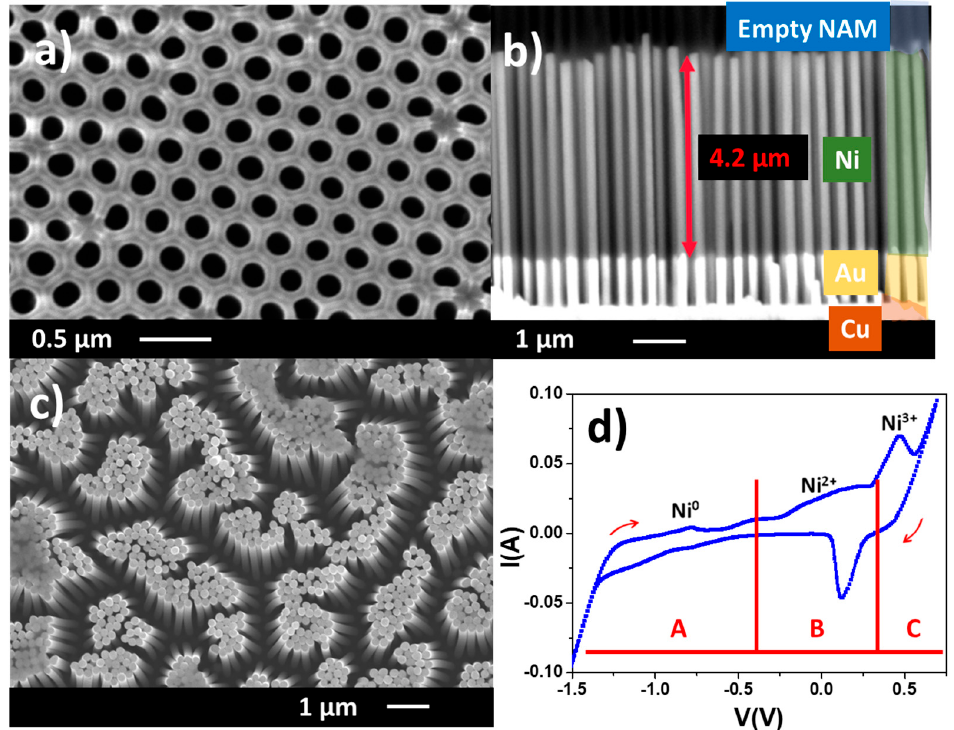
Figure 1. ( a ) Top-view SEM image of the NAM template and ( b ) cross-section view of the Ni nanowires array. ( c ) Top view of crowd Ni nanowires array after NAM removal. ( d ) Cyclic voltammetry curves of the Ni nanowires array sample; A, B and C regions mark off the different oxidation states. Red arrows highlight the respective ascendant and descendant branches of the cyclic voltammetry.